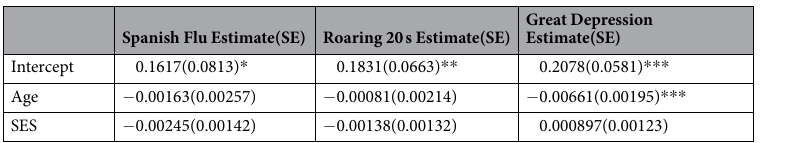
Table 4. Maternal age and socioeconomic status (SES) predicting sex ratio at birth by era. * p < 0.05, ** p < 0.01, *** p <